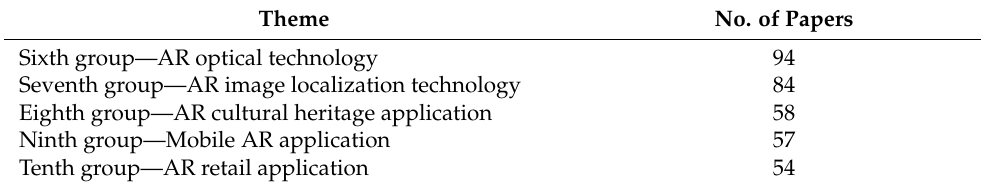
Table 3. Sixth to tenth major research topic